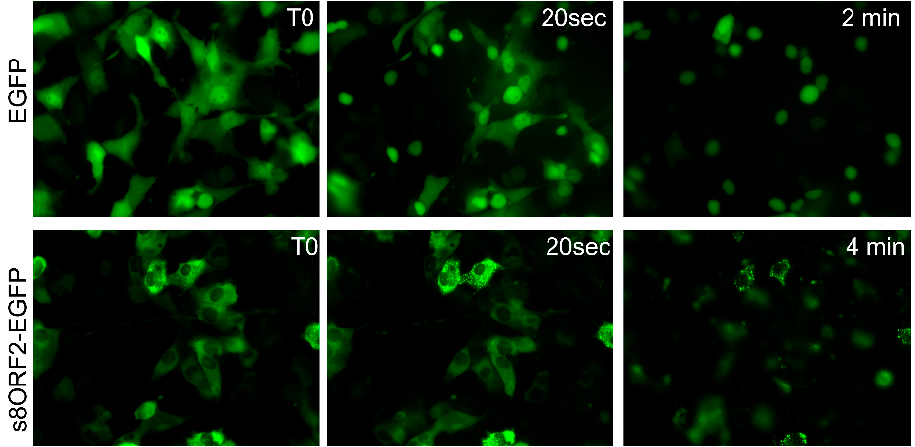
Figure 4. Live images of EPC cells transfected with constructs expressing EGFP or s8ORF2-EGFP captured with time-laps microscopy after permeabilization of cell membranes with digitonin. Cells were treated with a hypotonic buffer added 160 µM digitonin and images were captured at fixed intervals at 40× magnification in an inverted fluorescence microscope. T0 = time zero.